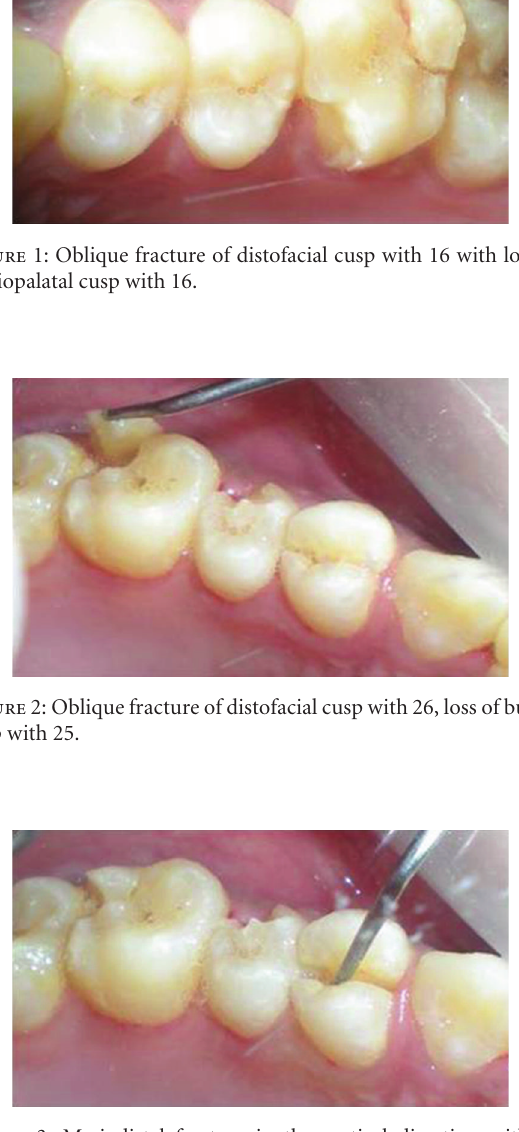
Figure 3: Mesiodistal fracture in the vertical direction with 24 extending subcrestally.